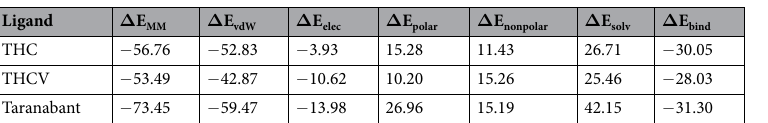
Table 2. Binding free energy components for the active CB1-ligand complexes determined by using the MM/ PBSA